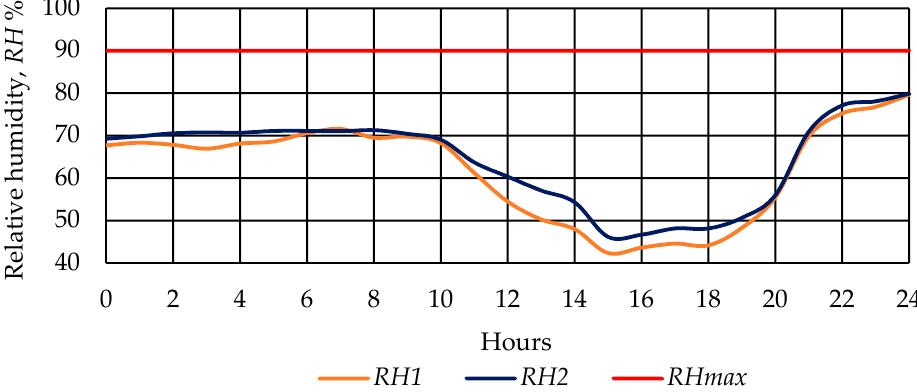
Figure 11. Temperature dynamics on a hot day (maximum temperature of 32.2 °C ).